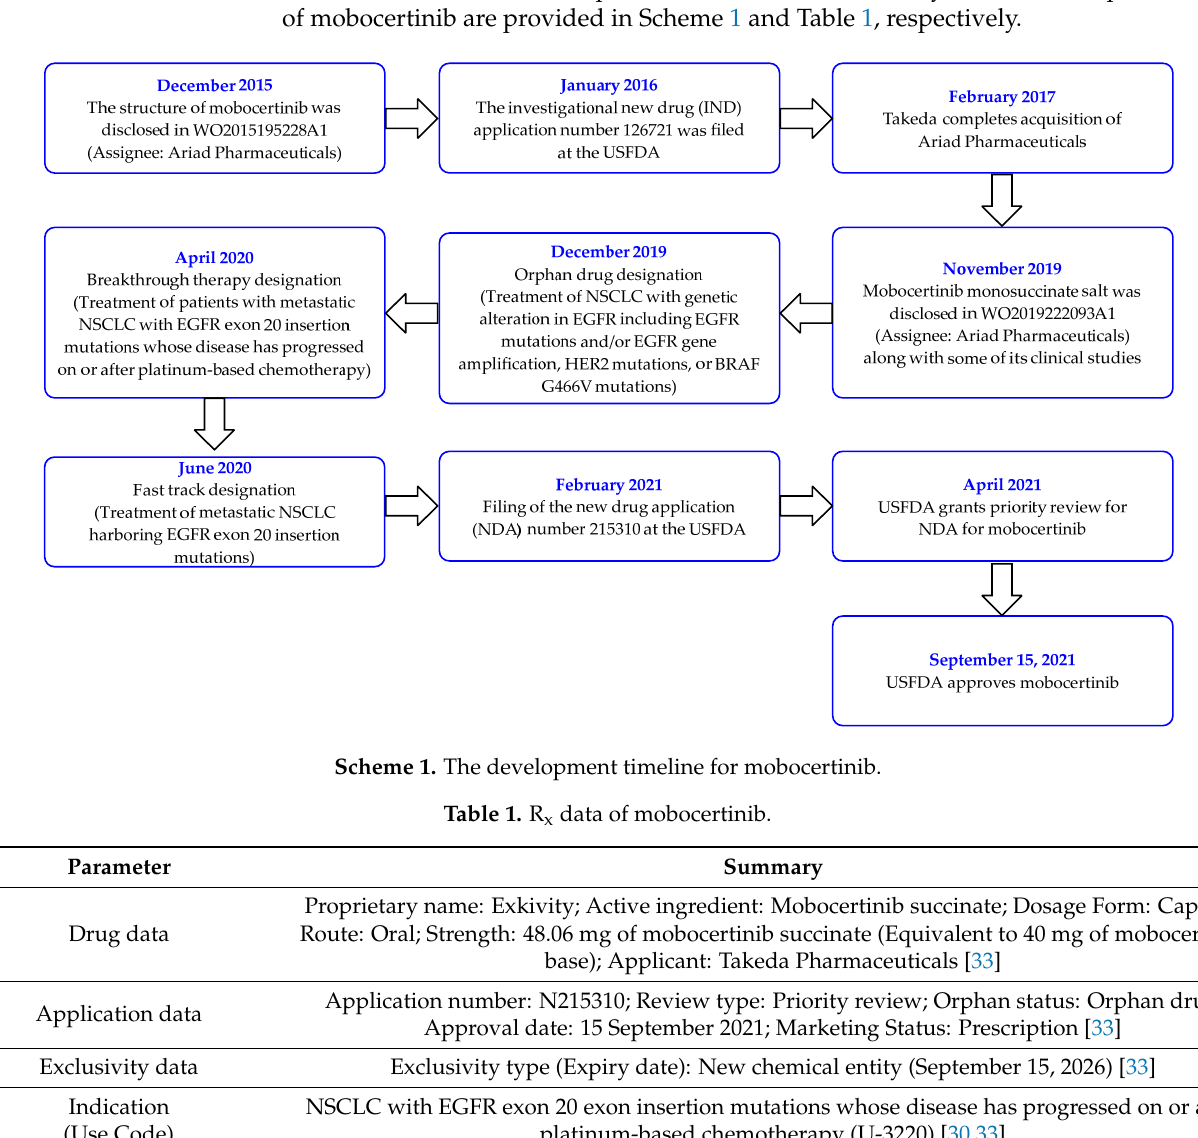
Figure 1. Chemical structure of mobocertinib.